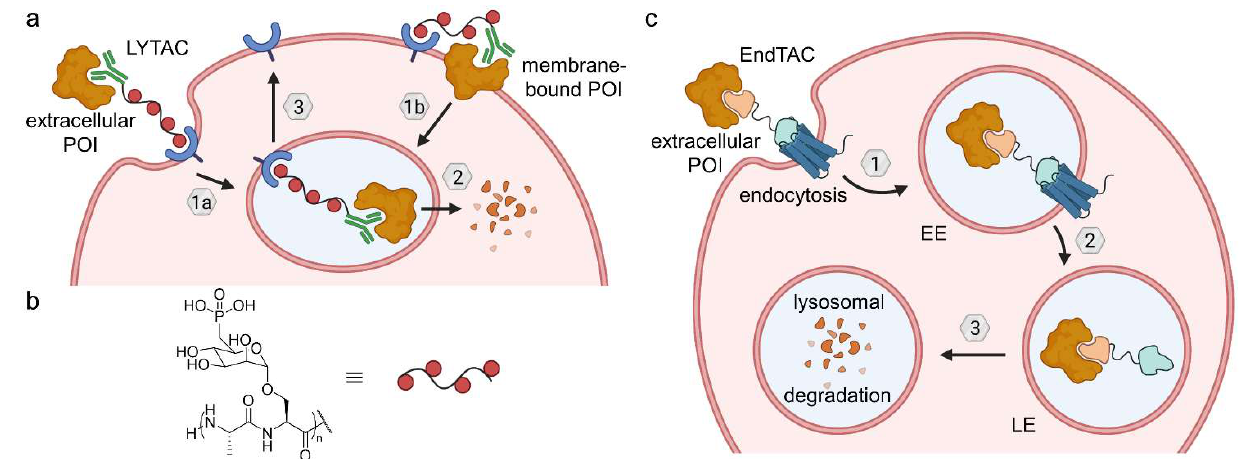
Figure 20. Lysosome-targeting chimeras (LYTACs) and endosome-targeting chimeras (ENDTACs). ( a ) LYTACs either target extracellular (1a) or membrane-bound POIs (1b), which are recognized by an antibody and trafficked to the lysosome (2) by a polyglycopeptide ligand for CI-M6PR. After lysosomal POI degradation, CI-M6PR returns to the cell surface (3). ( b ) The glycopeptide backbone is based on serine- O -mannose-6-phosphonate (M6Pn). ( c ) ENDTACs target secreted proteins and undergo endocytosis (1) mediated by a decoy GPCR, followed by lysosomal degradation (2 and 3). EE—early endosome, LE—late endosome.